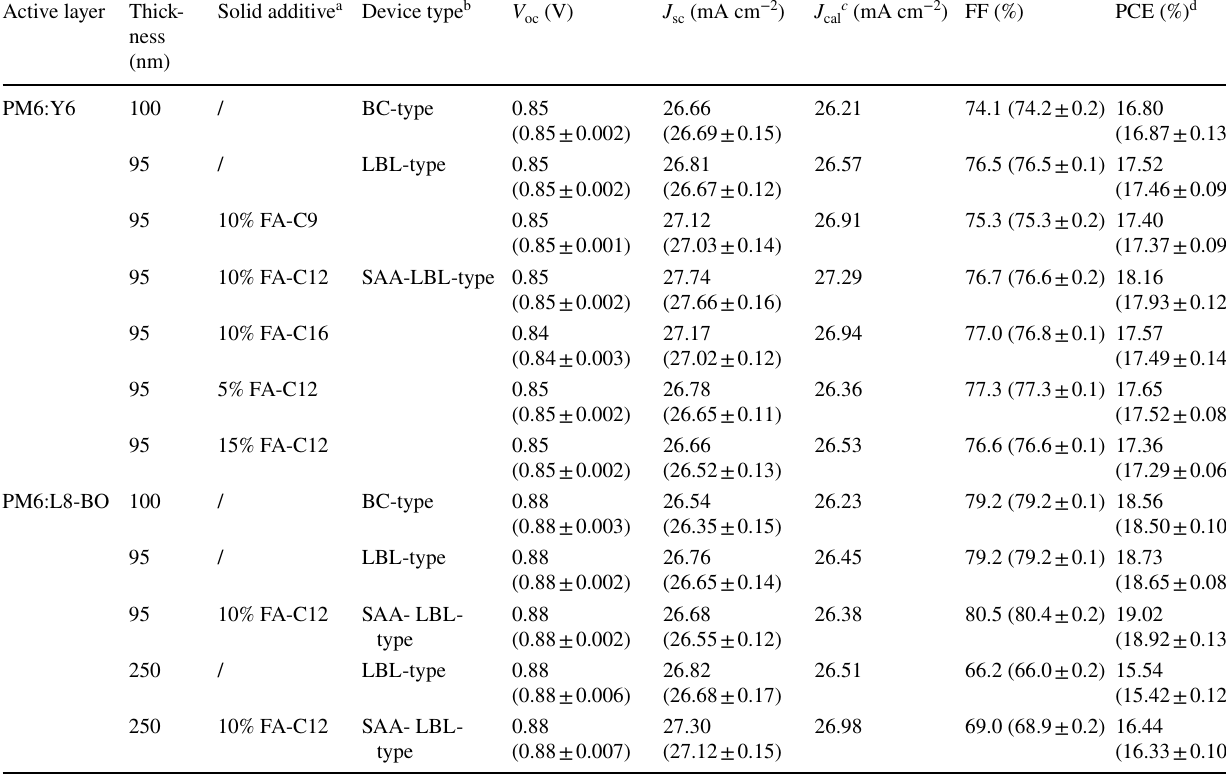
Table 1 Photovoltaic parameters of BC-type, LBL-type and SAA-LBL-type OSCs